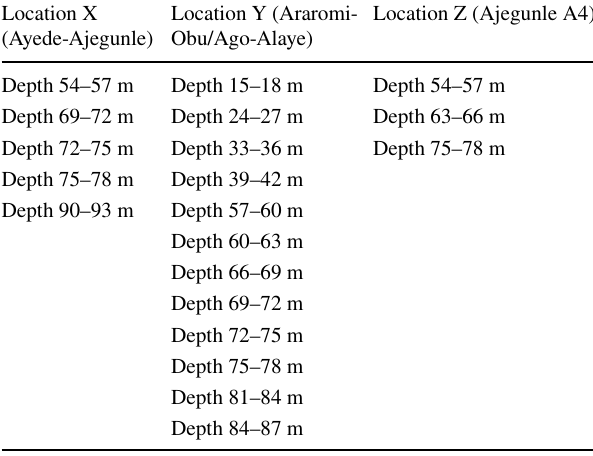
Table 2 Core holes and samples